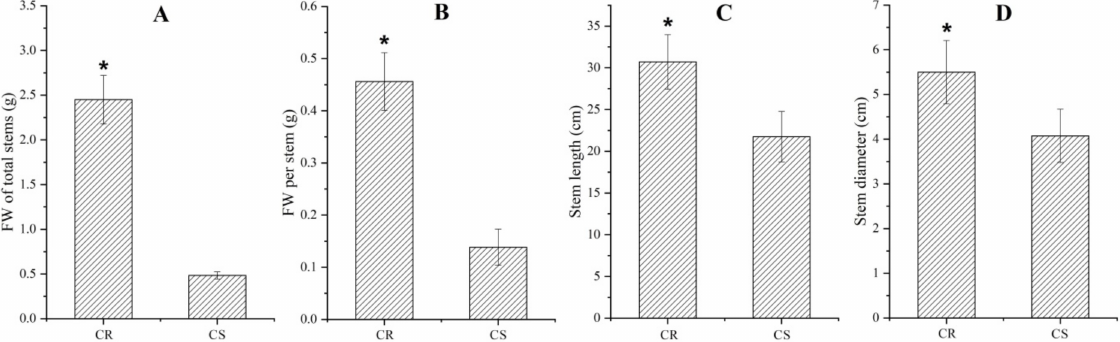
Figure 1. Growth characteristics of stems of Cynomorium songaricum host in Nitraria roborowskii (CR) and Cynomorium songaricum host in Nitraria sibirica (CS) (mean ± SD, n = 20). Images ( A – D ) represent FW of total stems, FW per stem, stem length and diameter, respectively. A t-test was applied for independent samples, the “*” is considered significant at p < 0.05 between CR and